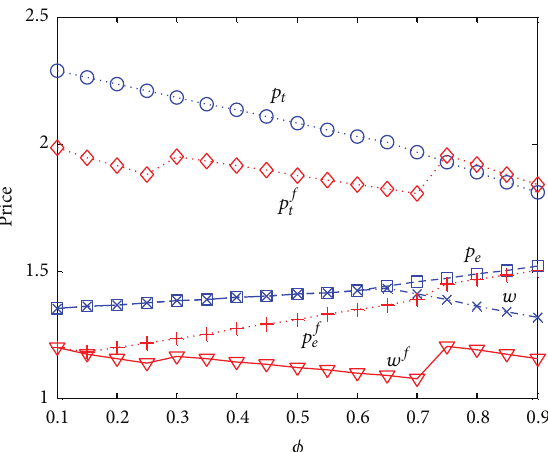
Figure 1: The effect of market share and channel on price.